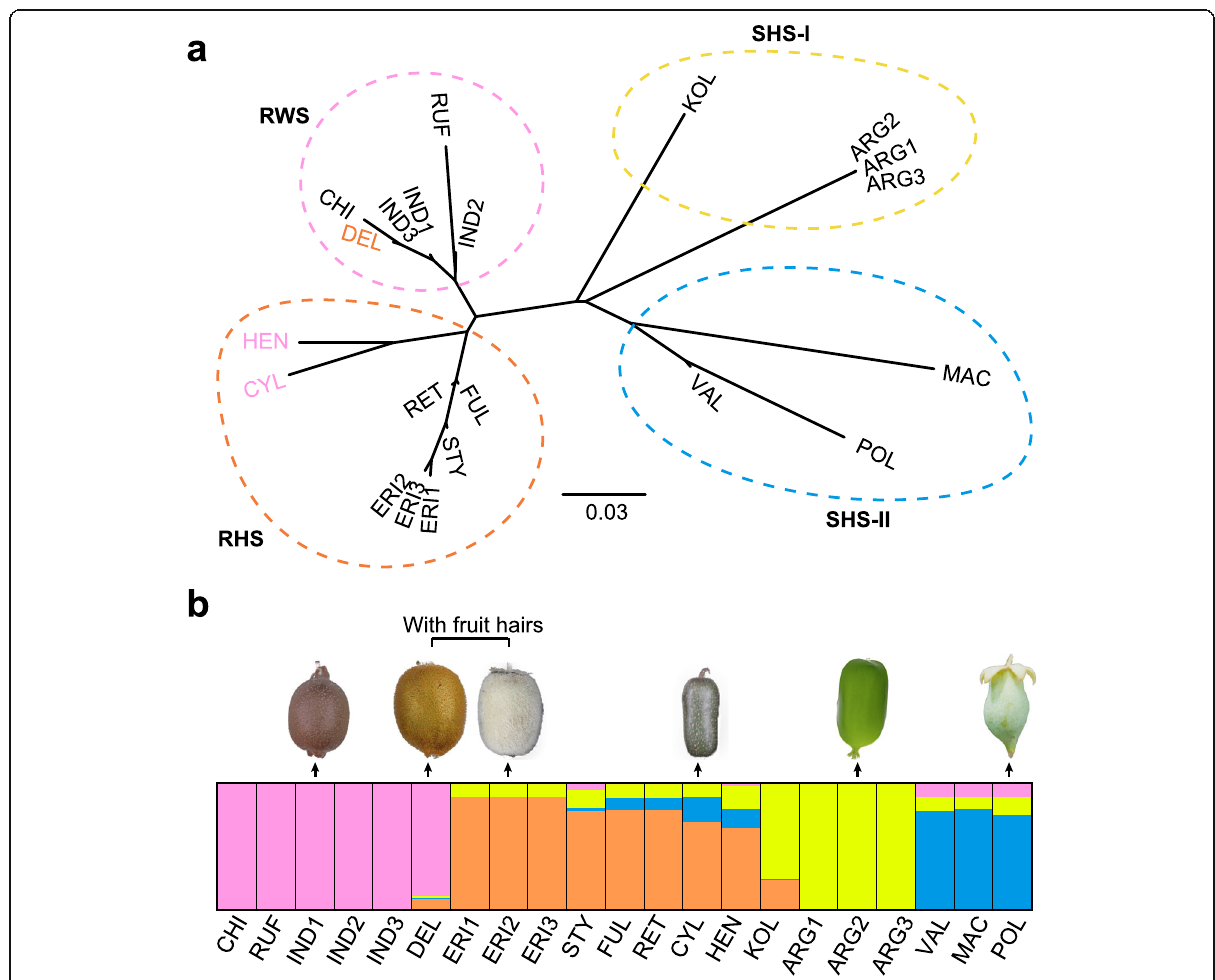
Fig. 4 Evolutionary relationship of Actinidia taxa with diverse fruit skin types. a A neighbor-joining tree showing the genetic relationship of species investigated. Two subgroups I and II of SHS are identified. b Results of STRUCTURE analyses revealing widely genomic admixture of many Actinidia taxa. See Supplementary Table 17 for the full name of the abbreviation of each taxon. RHS: rough and hairy skins; RWS: rough and warty skins; SHS: soft and hairless